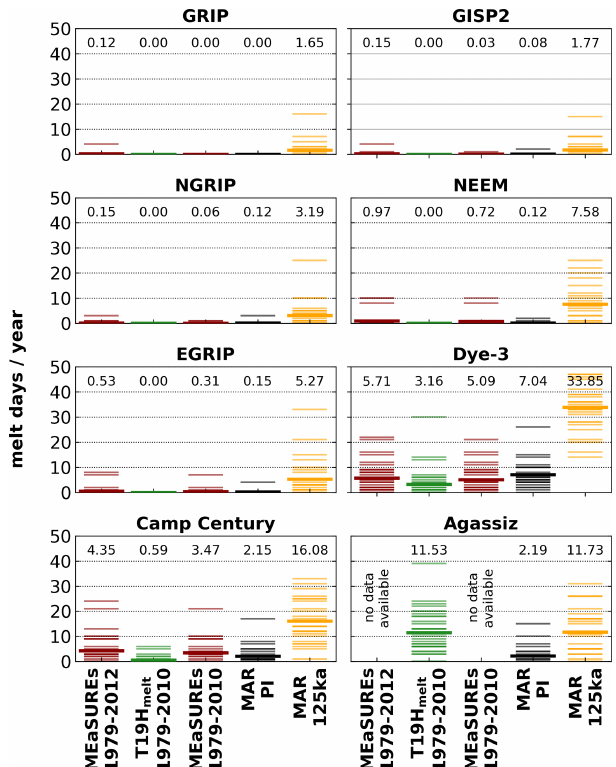
Figure 5. Annual refreezing percentage (of accumulation) at Greenland ice core locations simulated by the MAR climate model for three time slices. Individual model year percentages (thin lines) and the simulation ensemble mean percentages (bold lines, numer- ical values on top of columns) are